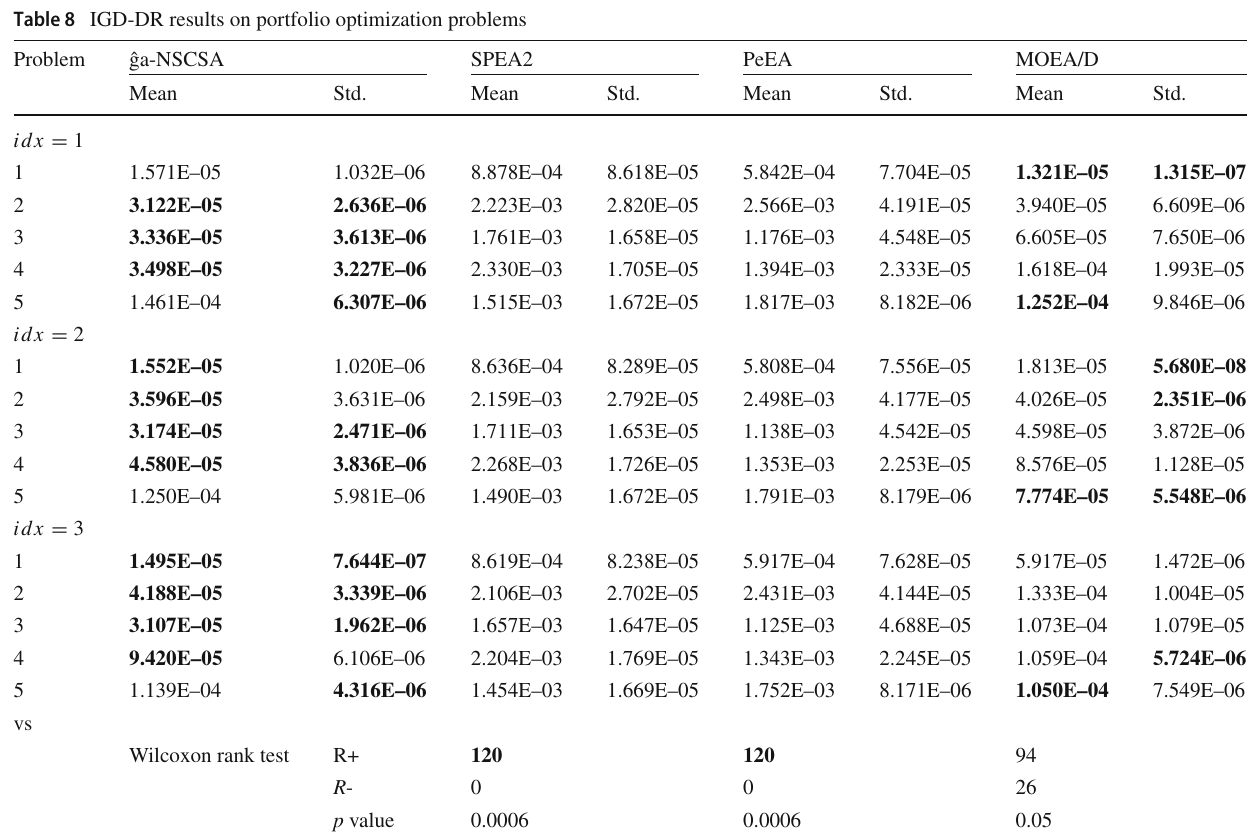
Table 8 IGD-DR results on portfolio optimization